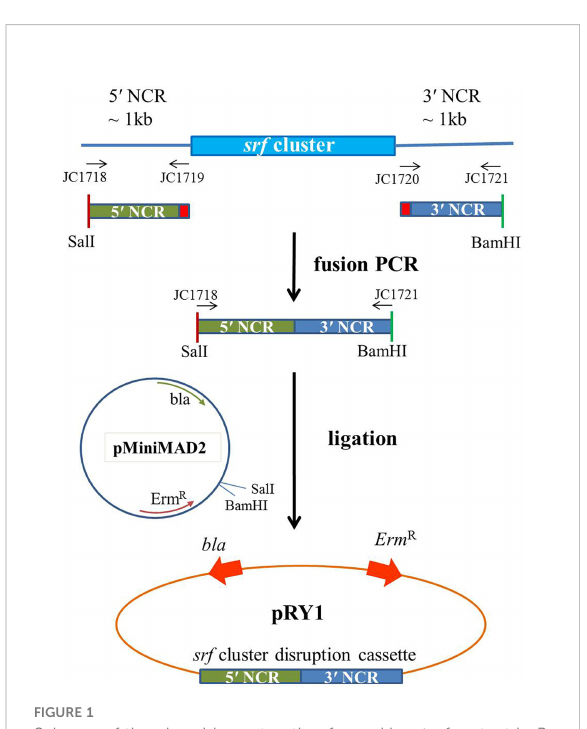
FIGURE 1 Scheme of the plasmid construction for making D srf mutant in B amyloliquefaciens Ba01. Primers JC1718/1719 and JC1720/1721 were used to amplify 5 ′ and 3 ′ NCR sequences of srf gene cluster of B amyloliquefaciens Ba01, respectively, and fused together by fusion PCR using primers JC1718/1721. After enzyme digestions the ~2 kb cassette was ligated to pMiniMAD2 in order to generate disruption plasmid